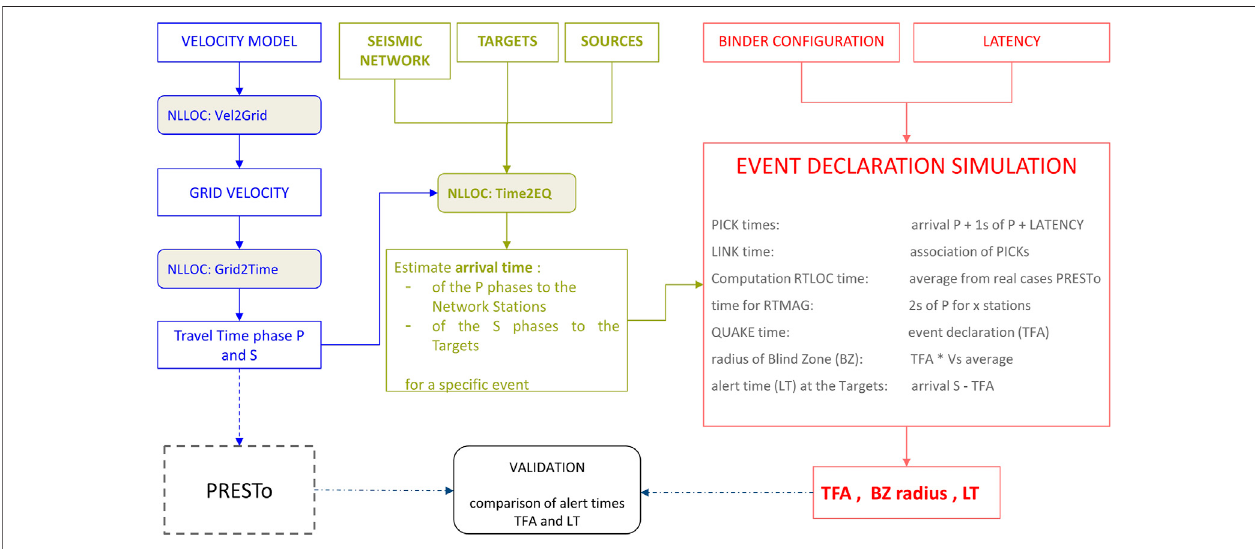
FIGURE2| FlowchartoftheEDSmethod. Left (blue):PandStraveltimecalculationwithNonLinLocsoftwaremodules(Lomaxetal.,2009). Middle (green):Pand S arrival time relative at seismic stations and targets respectively. Right (red): input parameters and elements of the EDS core. Bottom : terms of the validation.